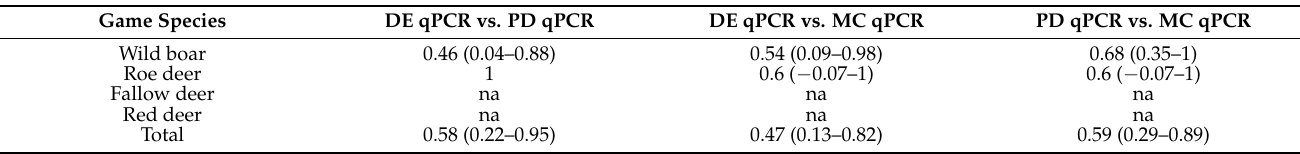
Table 4. Concordance between DE qPCR, PD qPCR and MC qPCR measured in kappa values ( κ (95% CI)) among individuals analysed by all three methods.